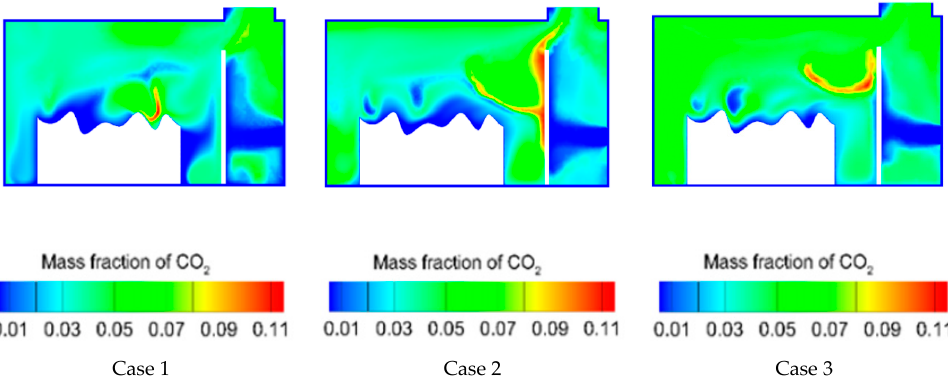
Processes 2020 , 8 , x FOR PEER REVIEW Figure 9. Mass fraction of CO 2 for di ff erent mass flow rates of the cooling air. Figure 9. Mass fraction of CO 2 for different mass flow rates of the cooling air.